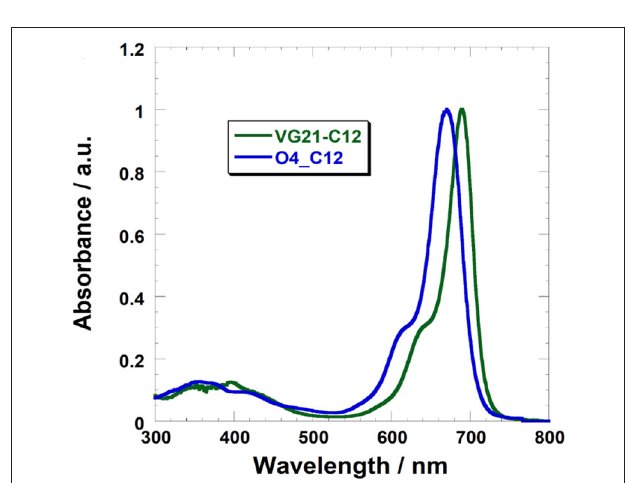
FIGURE 2 | UV-Vis absorption spectra of VG21-C12 (green) and O4-C12 (blue) in ethanol solution.